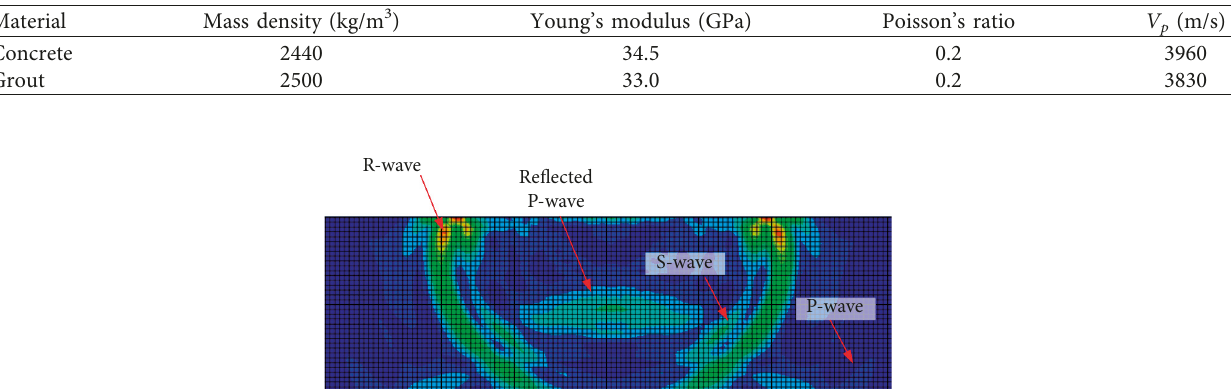
Table 2: Material properties.